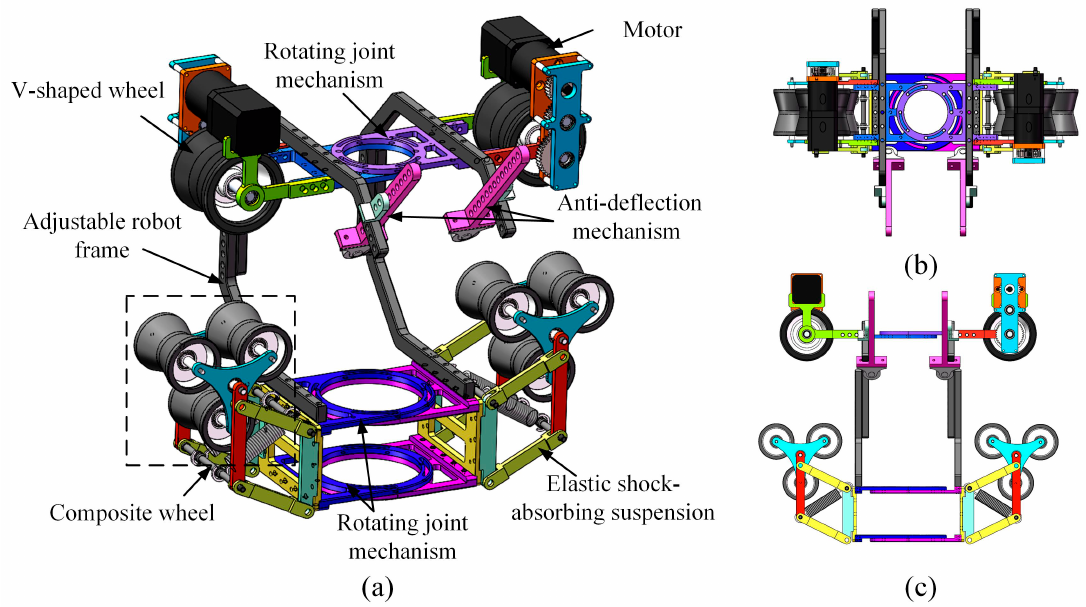
Figure 2. Mechanical structure of the pipeline-climbing robot: ( a ) Overall view; ( b ) Top view; ( c ) Side view.